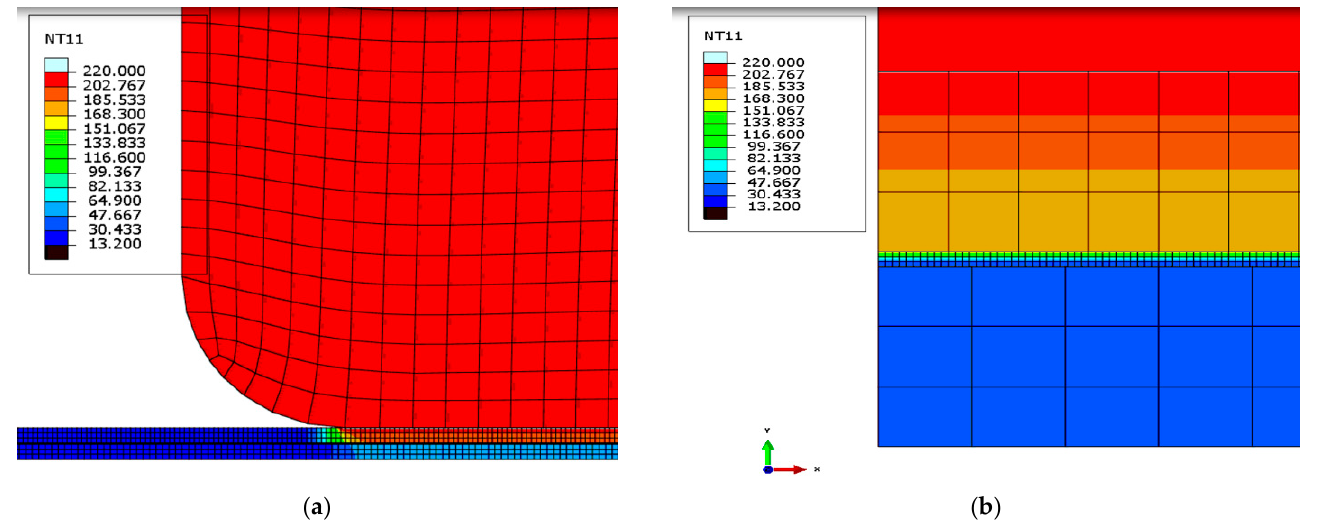
Figure 10. ( a ) Transient temperature distribution (central). ( b ) Detailed distribution (boundary).